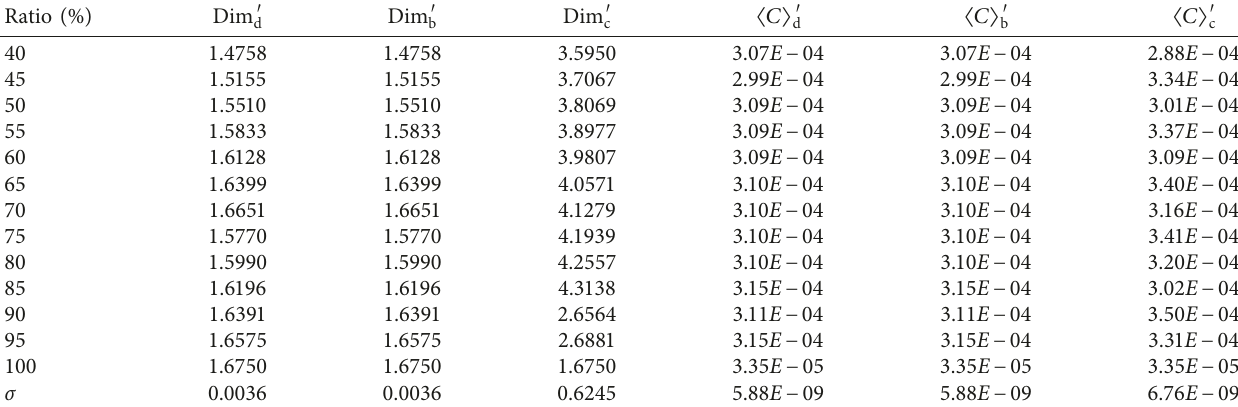
Table 3: Changes of box dimension and cluster coefficient of SFnet with nodes removal in the ascending